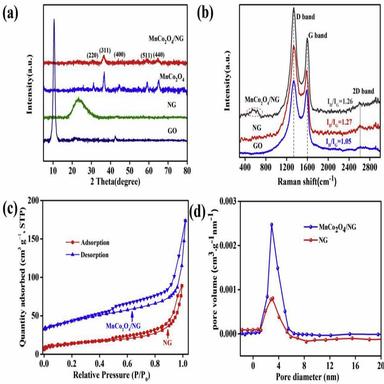
(a) XRD spectra of the GO, NG, 2D MnCo2O4 and MnCo2O4/NG 2D/2D hybrid nanoarchitectures, (b) Raman spectra of GO, NG and MnCo2O4/NG 2D/2D hybrid nanoarchitectures, and (c) BET adsorption isotherms (N2), (d) BJH pore size distribution plot of MnCo2O4/NG 2D/2D hybrid nanoarchitectures.